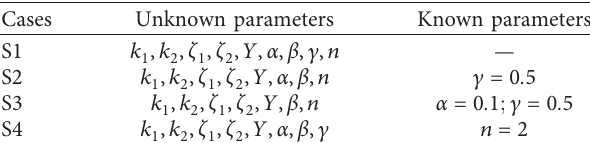
Figure 3: 2-DOF structure with Bouc–Wen model subjected to seismic excitation. Table 1: Different cases for